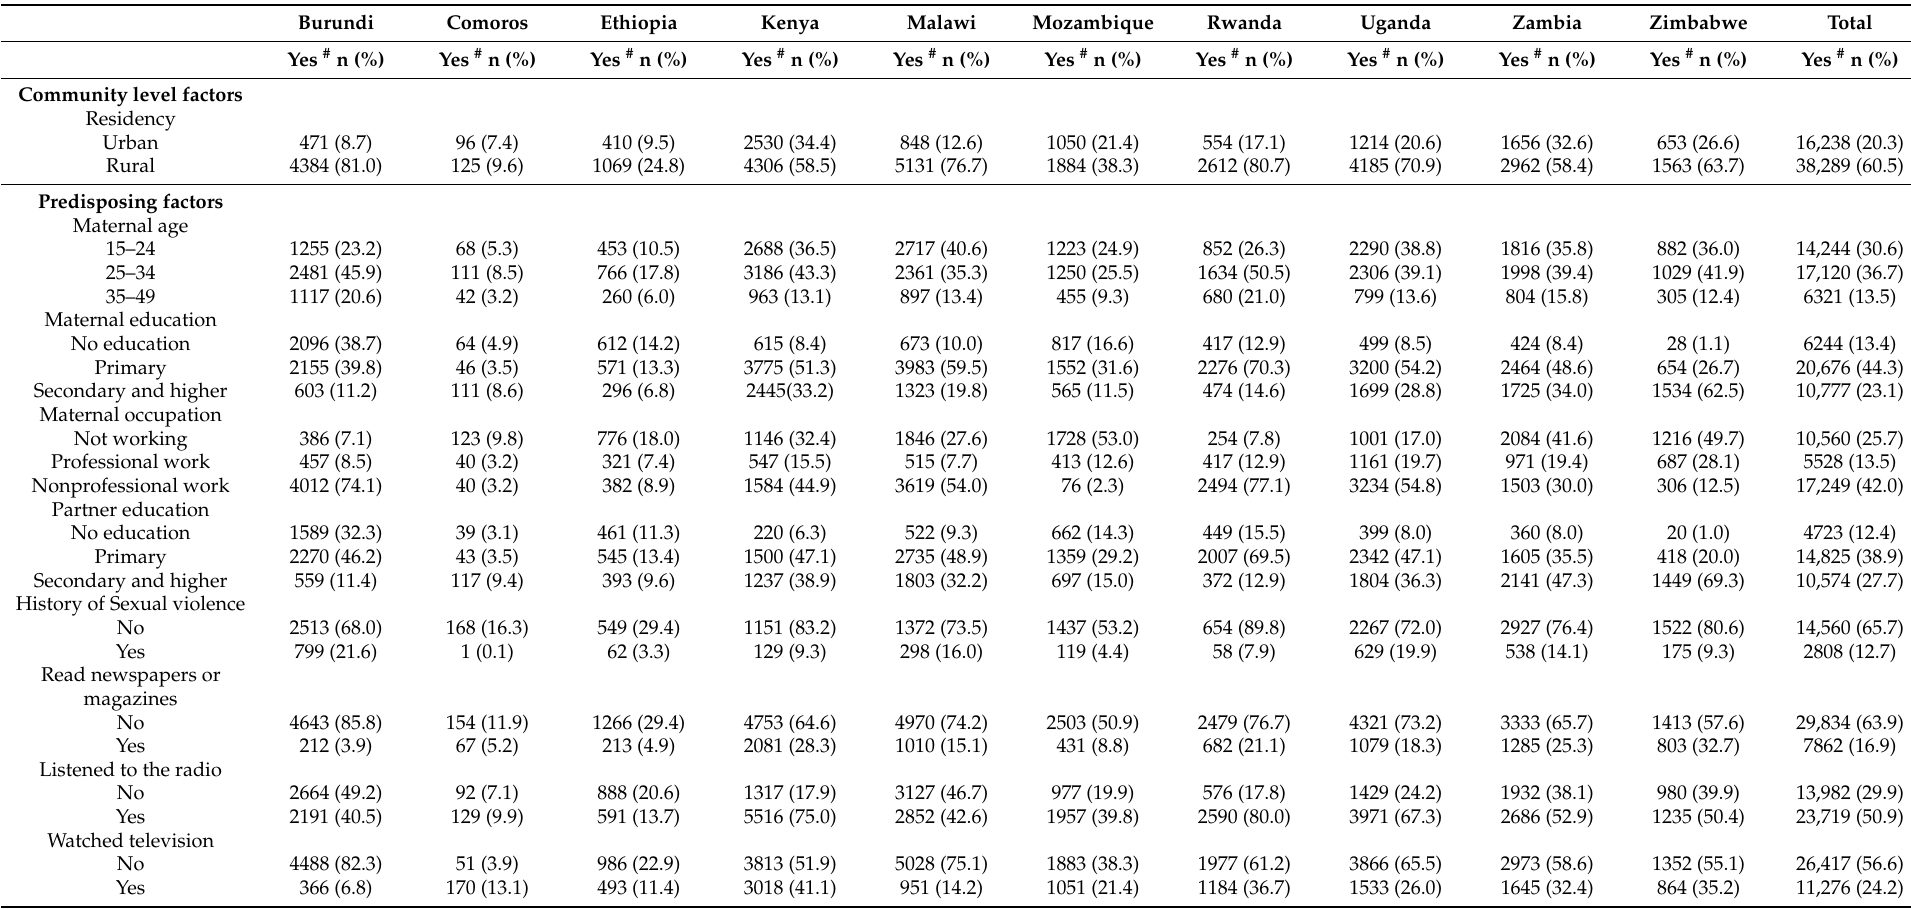
Table 1. Percentage of prenatal HIV test service user for PMTCT of HIV by study factors in East African countries (N = 46,645; Demographic and Health Survey, 2011–2017).